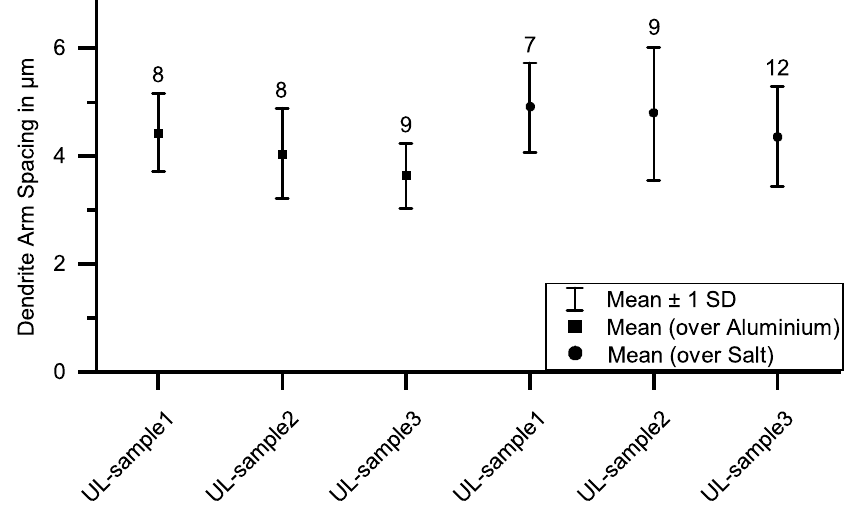
Figure 8. Dendrite arm spacing in the aluminum part (UL-sample). The squares show the dendrite arm spacing in the area above the aluminum and the circles show the dendrite arm spacing above the salt support structure. The numbers above the result points show the number of measurements performed. Based on the measurements, a larger dendrite arm spacing tends to be observed in the area above the salt support